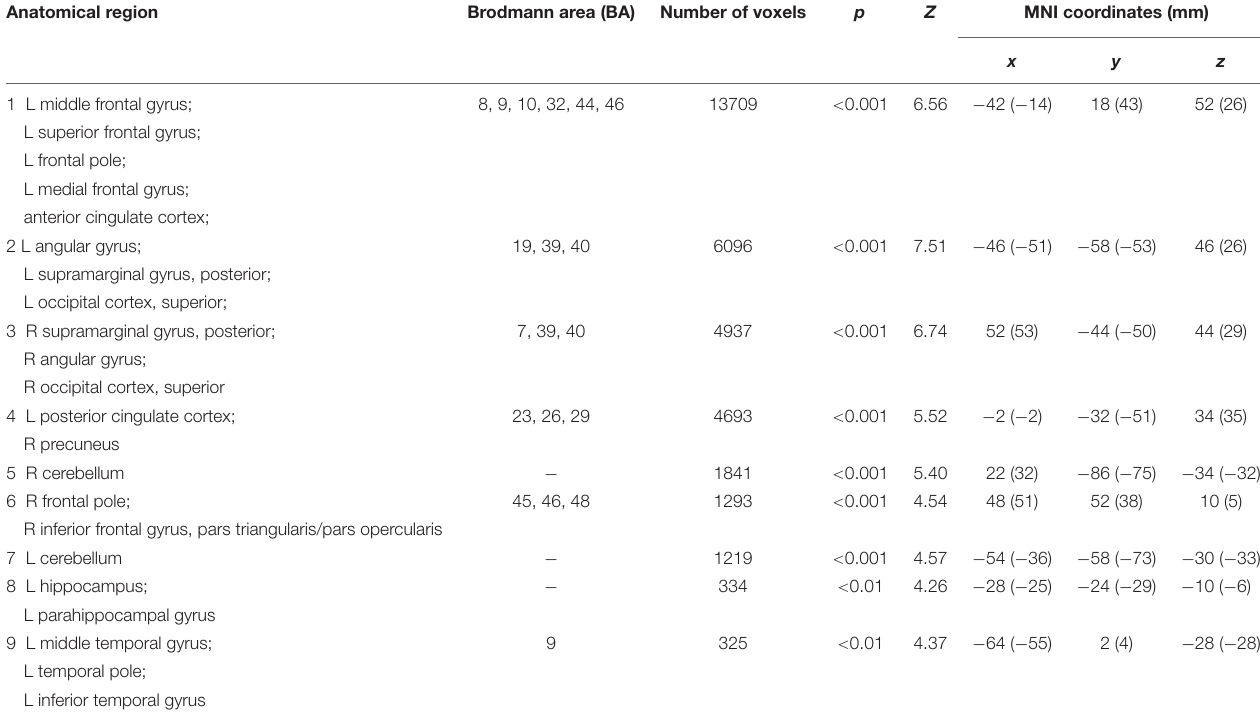
FIGURE 4 | Functional magnetic resonance imaging (FMRI) contrast for the CRA vs. control condition during the presentation of the solution. Unfitting responses (i.e., “plausible” for control and “implausible” for CRA) were excluded. White–red activation clusters indicate CRA > control and green-blue activations indicate CRA < control. TABLE 2 | Activation clusters for the insight (solvable CRAT) > no-insight (control) contrast during the presentation of the solution. Anatomical region Brodmann area (BA) Number of voxels p Z MNI coordinates